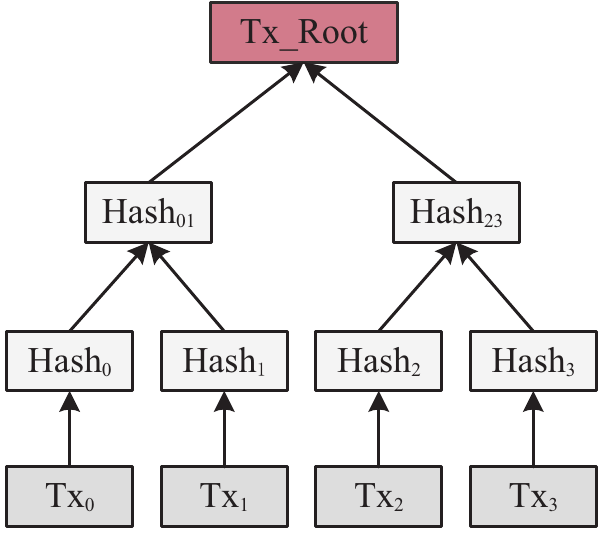
Figure 5. Merkle